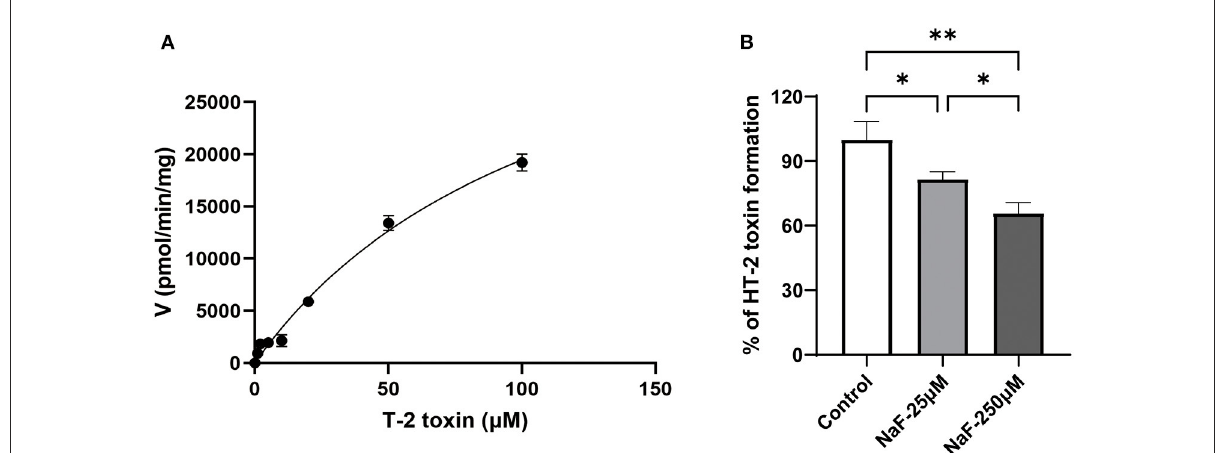
FIGURE2 Sodium fluoride inhibits CES1-mediated T-2 toxin hydrolysis. (A) Kinetic analysis of T-2 toxin to form HT-2 toxin in recombinant human CES1; (B) Sodium fluoride inhibited the generation of HT-2 toxin from T-2 toxin in recombinant human CES1, with the concentration at 25 and 250 µ M, respectively. Data are presented as mean ± SD ( n = 6 each). * P < 0.05, ** P < 0.01. NaF, sodium fluoride.